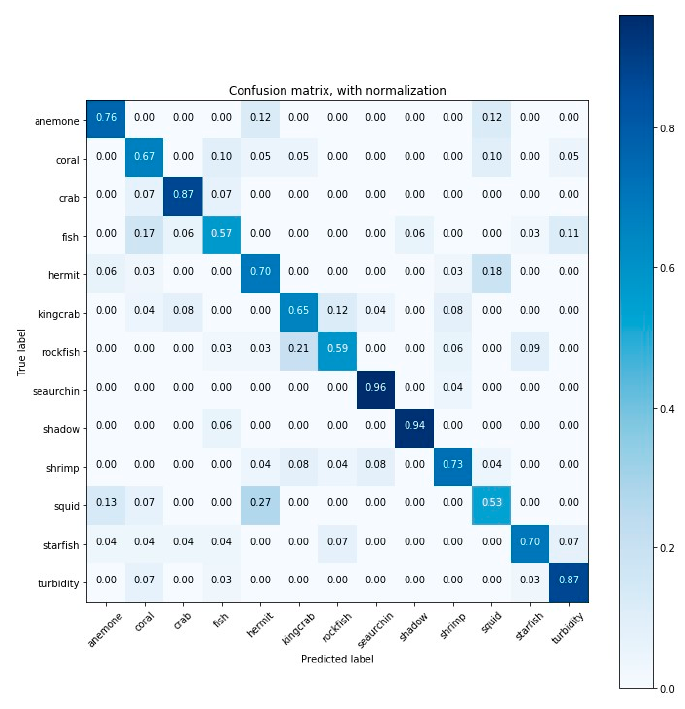
Figure A7. Confusion matrix for the classification results (accuracy) obtained by RF-1.